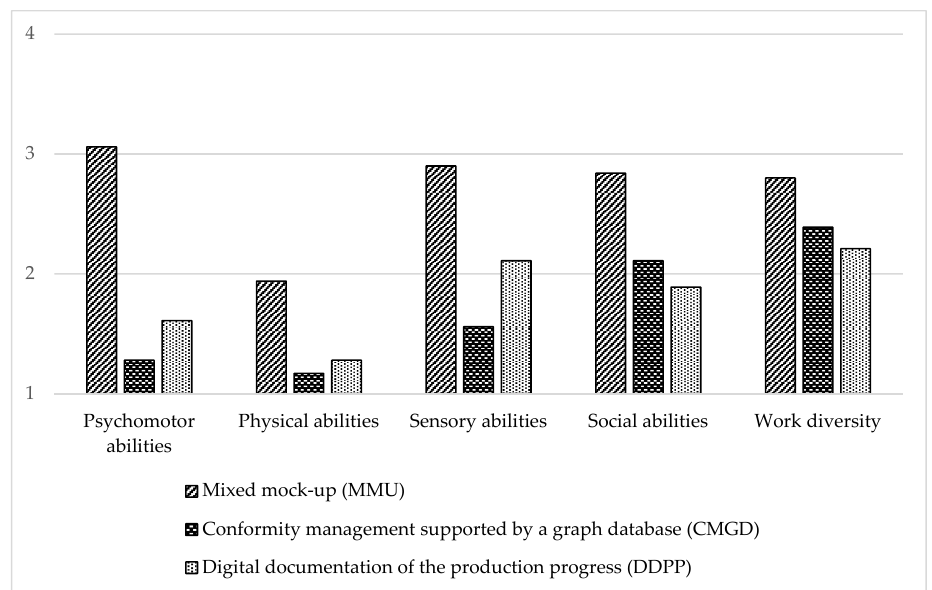
Figure 1. Means of the criteria on the human dimension with statistically significant differences between the three scenarios.